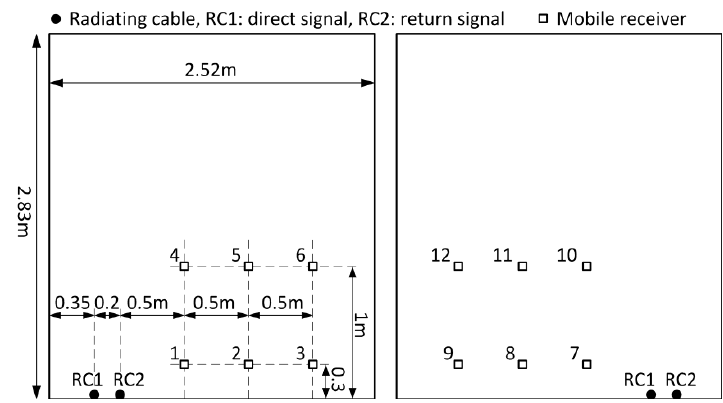
Figure 7. Position of radiating cables and receiving antenna in a corridor in the scenario with two feeders and frequency conversion.